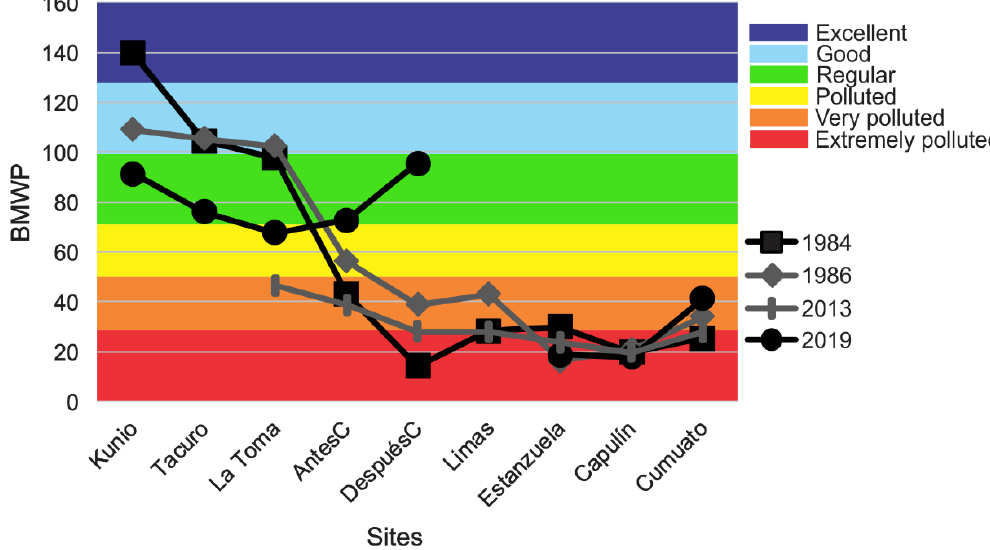
Figure 4. Comparison of the BMWP in different years in the Duero river. Sites are presented in order from upstream to downstream. AntesC = Antes Central de Abastos and DespuésC = Después Central de Abastos. BMWP scores shown in color. Table 4. Average values of the Habitat Quality Index (HQI), the Water Quality Index (NSFWQI), the Ephemeroptera, Plecoptera, Trichoptera index minus Baetidae (EPT-B), and the BMWP, including their interpretation. AntesC = Antes Central de Abastos y Despu é sC = Despu é s Central de Abastos. The Grey line indicates sites with contrasting interpretation of the